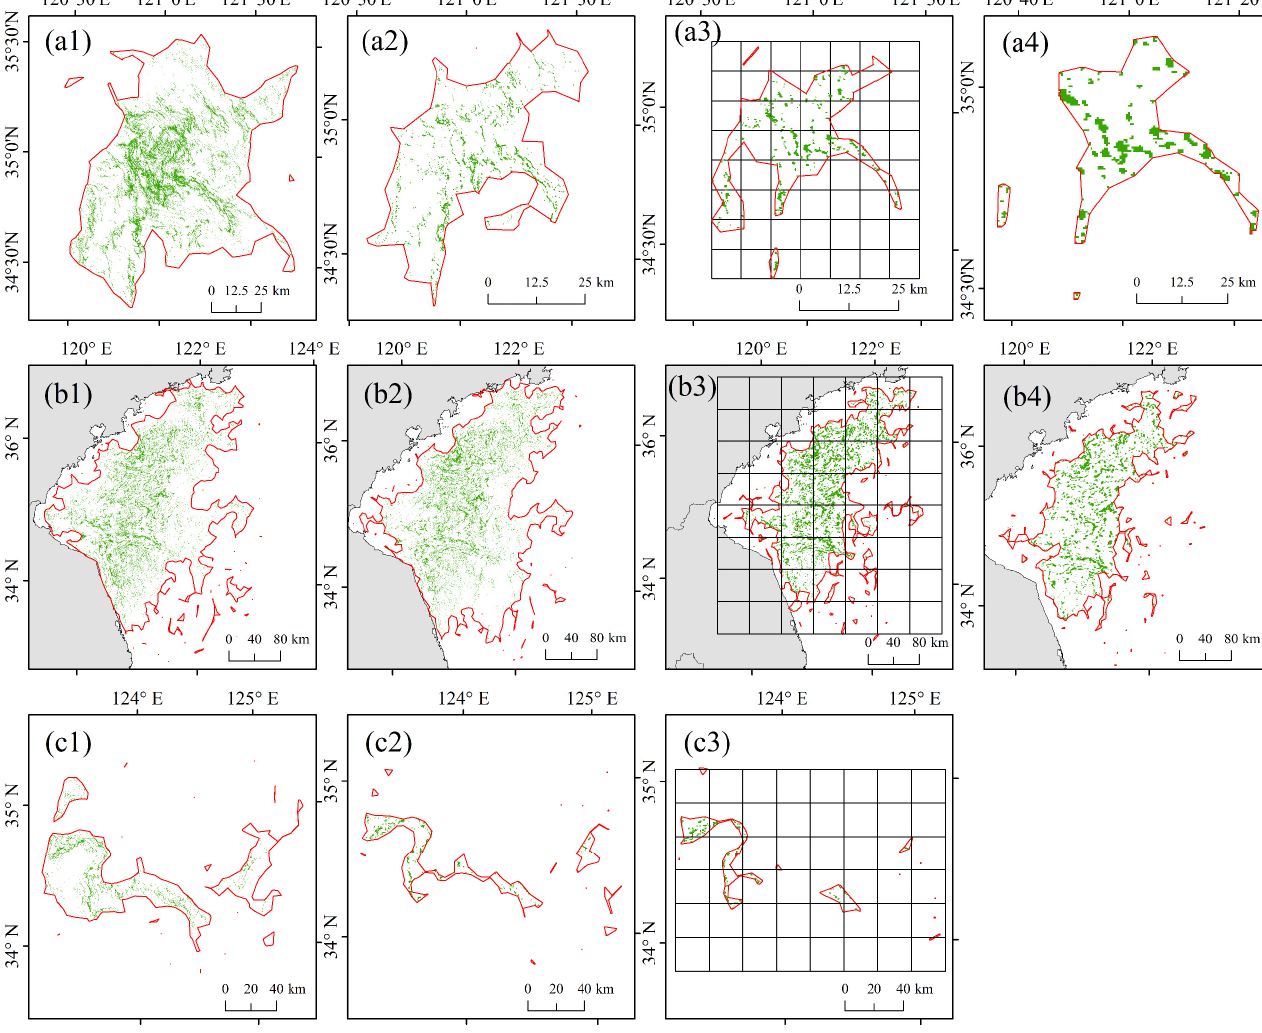
Figure 3. Comparison of spatial distribution of macroalgae obtained from images with different spatial resolutions. ( a1 – a4 , b1 – b4 , c1 – c3 ) are the images corresponding to those of A1–A4, B1–B4 and C1–C3 in Table 1, respectively. Table 2. MM-CA, AA, AD, OR AA and OR MM-CA of macroalgae in three groups of images. Satellite